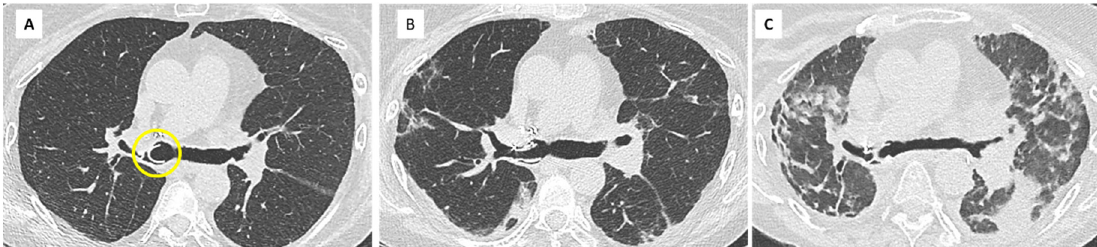
Figure 7. Acute exacerbation of RAS in a 67 ‐ year ‐ old woman; ( A ) baseline CT scan. Stable obstructive pattern on PFT related to right main bronchus stenosis, treated by endo ‐ bronchial stenting (yellow circle); ( B ) diagnosis of CLAD with restrictive profile. CT shows persistent subpleural opacities (ground glass mostly), consistent with RAS; ( C ) 1 month later, the patient presented with acute clinical and functional deterioration. CT shows extensive and rapidly progressive ground glass opacities, suggesting diffuse alveolar damage and/or AFOP. The patient died a few days